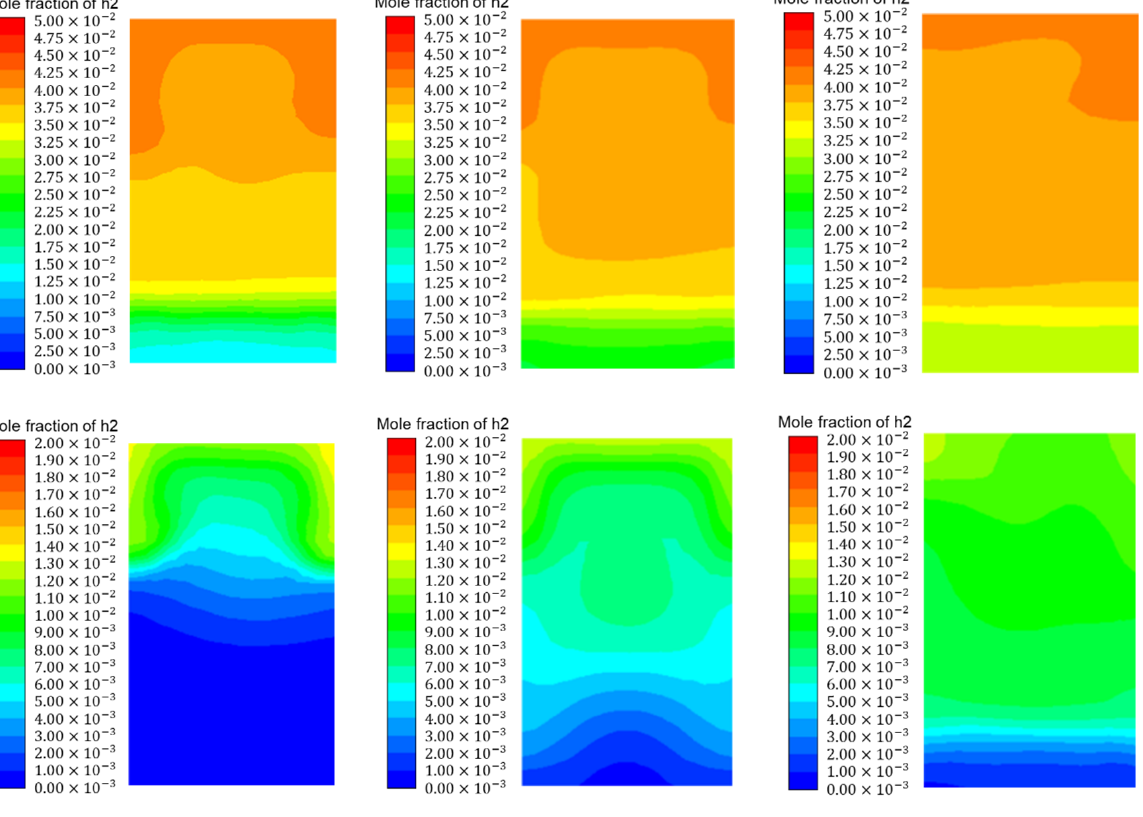
Model 5 Figure 10. Contours of mole concentration of hydrogen for Model 1–Model 5 after the envelope of 4% mole fraction (up) and 1% mole fraction (down) of hydrogen filling the whole ceiling.